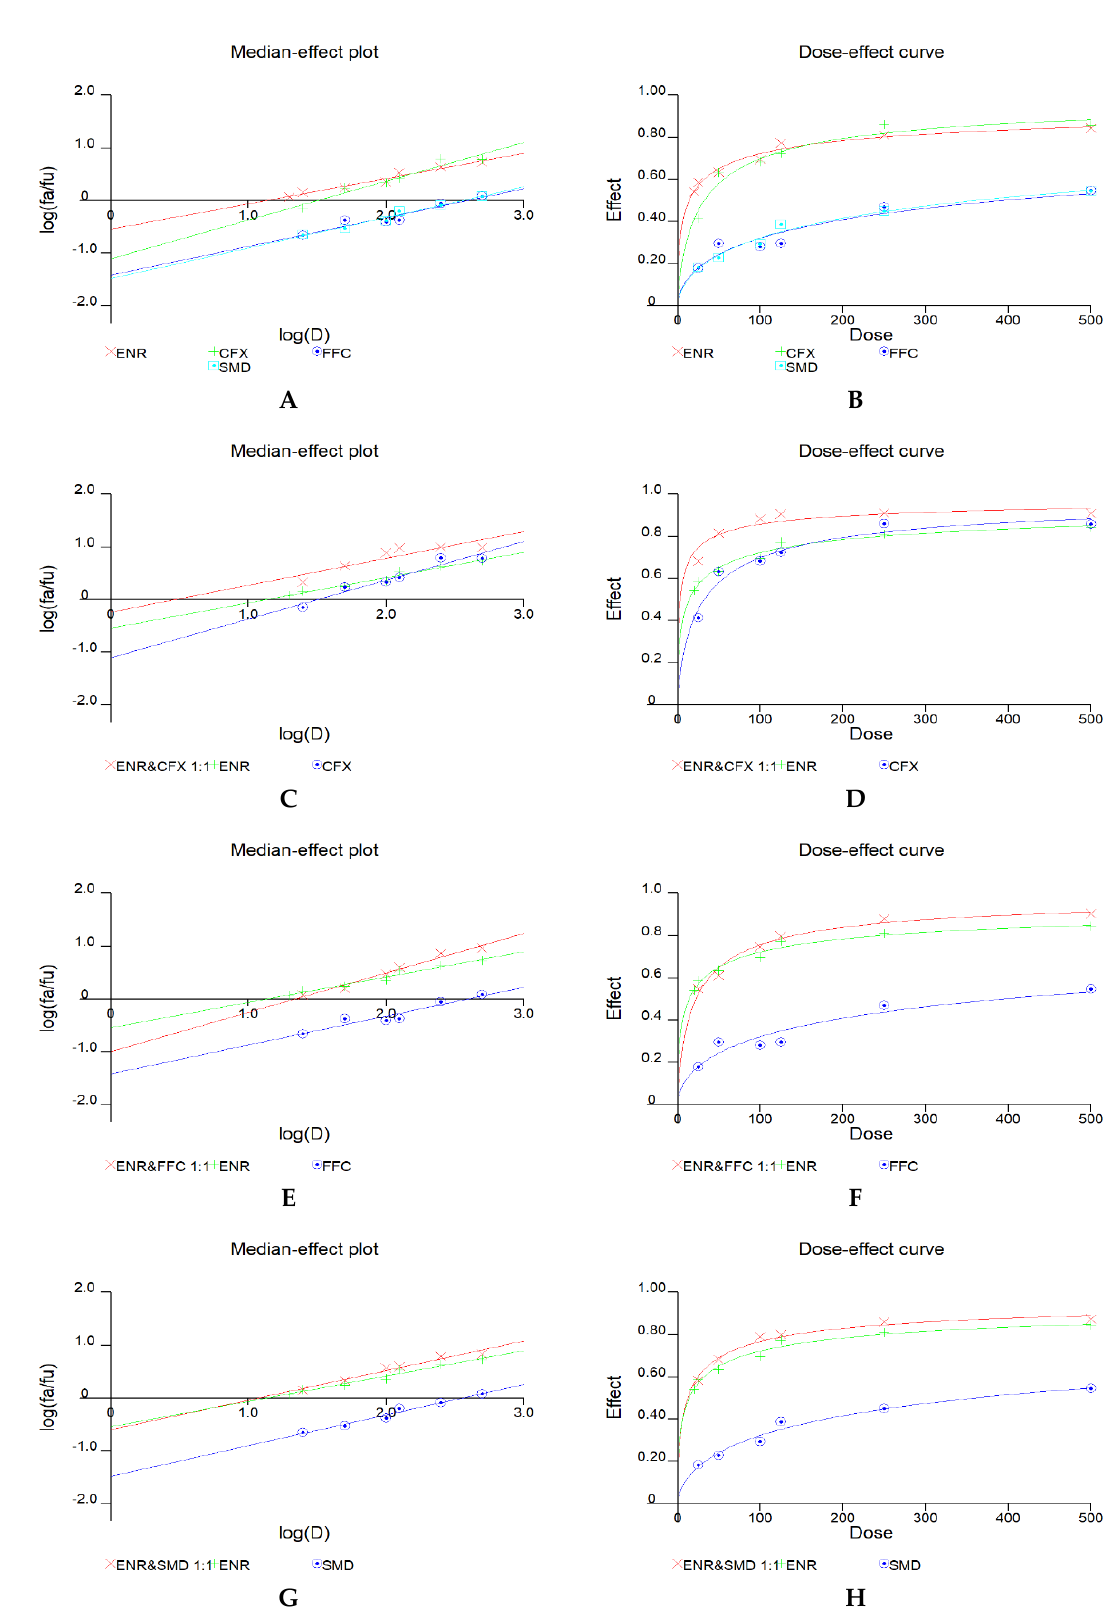
Figure 1. Median-effect plots and dose – effect curves of single drugs ( A , B ) and binary drug combinations mixed at a ratio of 1:1 ( C – H ).